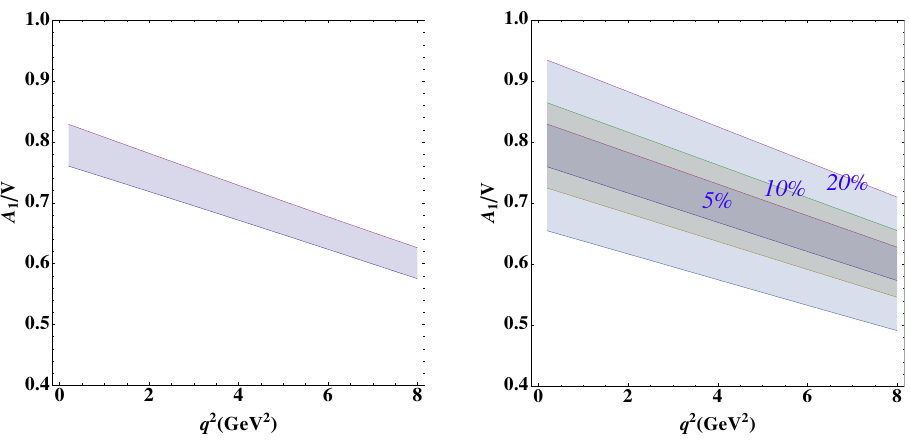
Figure 1 . Ratio of form factors A 1 =V applying the full and soft form factor approaches to the results of ref. [18]. Left: error band according to the LCSR calculation from ref. [18]. Right: error bands following the soft form factor approach with (cid:14) = 5% ; 10% ; 20% power corrections. r ( q 2 ) yields 10% for these estimates for all form factors, except for A power corrections are not independent but follow from correlations among form